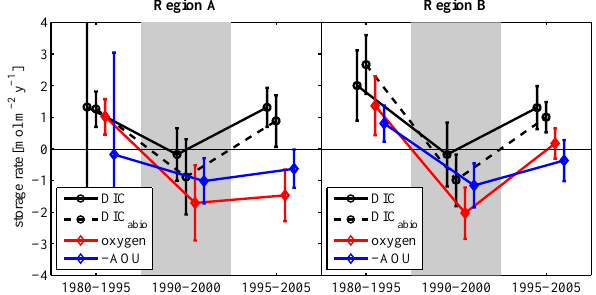
Fig. 11. Storage rates for DIC, DIC abio , AOU and oxygen for re- gions A and B for three time periods (1980–1995, 1990–2000, and 1995–2005), see Figs. 6–9. Note that negative AOU is plotted and that the markers are slightly offset for clarity. The error-bars the 95% confidence interval of the variation of storage rates within each area calculated from the values of the 2 ◦ × 2 ◦ bins (see